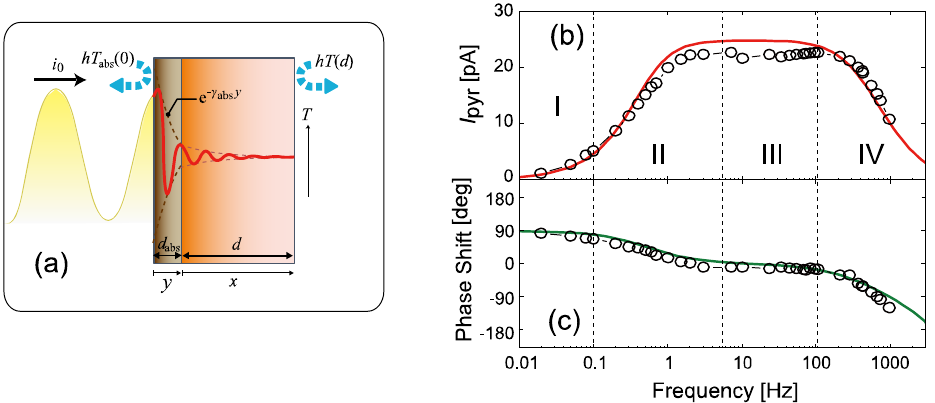
Figure 5. ( a ) Schematic diagram of the temperature distribution of a two-layer model heated by modulated light in a heat exchange gas. The distribution is represented as a two-step decaying wave, in which the presence of the inverse wave and time-independent terms are omitted. ( b , c ) Comparison between the experimental data and the simulated pyroelectricity and the phase shift calculated using the two-layer model.